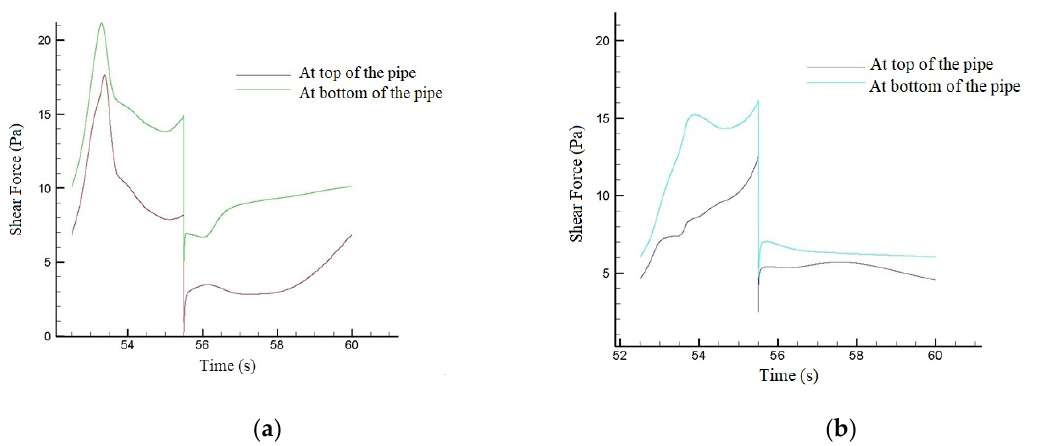
Figure 8. The shear force at the top and bottom of the pipe at the first and second pressure test points: ( a ) the first pressure test point; ( b ) the second pressure test point.